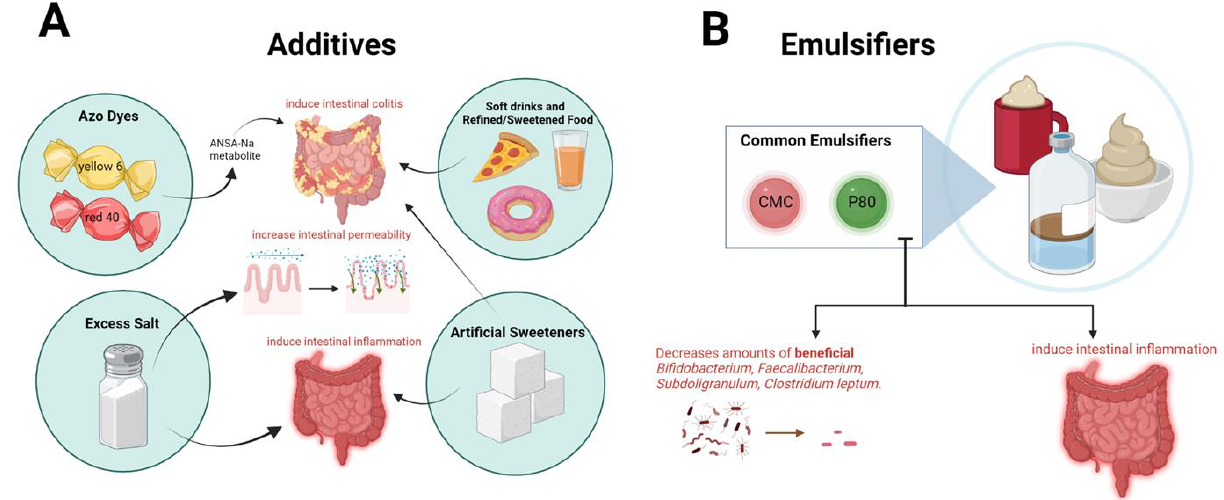
Figure 1. Ultra-processed Foods and Food Additives in IBD. ( A ) Additives and their effects on IBD: Excessive salt and artificial sweeteners can promote intestinal inflammation and induce colitis. Higher salt concentrations have been shown to increase intestinal permeability, increase inflammatory cytokine production through a reduction in fecal short-chain fatty acid production and depletion of Lactobacillus, and exacerbate chemically induced colitis in experimental models. Artificial sweeteners in UPFs may also induce gut inflammation, as seen in mice models of spontaneous ileitis with sucralose/maltodextrin supplementation. Azo dyes red 40 and yellow 6, the most abundant synthetic food coloring used by the food industry, can trigger IBD-like colitis in genetically susceptible mice. Consumption of ≥ 3 servings/week of soft drinks, consumption of ≥ 100 g/day of refined, sweetened foods, and consumption of ≥ 100 g/day of salty snacks were all associated with a higher risk of IBD. ( B ) Common Emulsifiers P80 and CMC effects on Gut and Microbiome: P80 and CMC are the most studied emulsifiers. They have been found to cause similar alterations to human gut microbiomes as does IBD. CMC and P80 are found in edible oils, ice creams, cake mixes, icing, and chocolate syrup, but ingestion of them has led to reduced numbers of beneficial Bifidobacterium and important SCFA producers—Faecalibacterium and Subdoligranulum—and Clostridium leptum. These same microbiota alterations by P80 and CMC in mice led to chronic intestinal